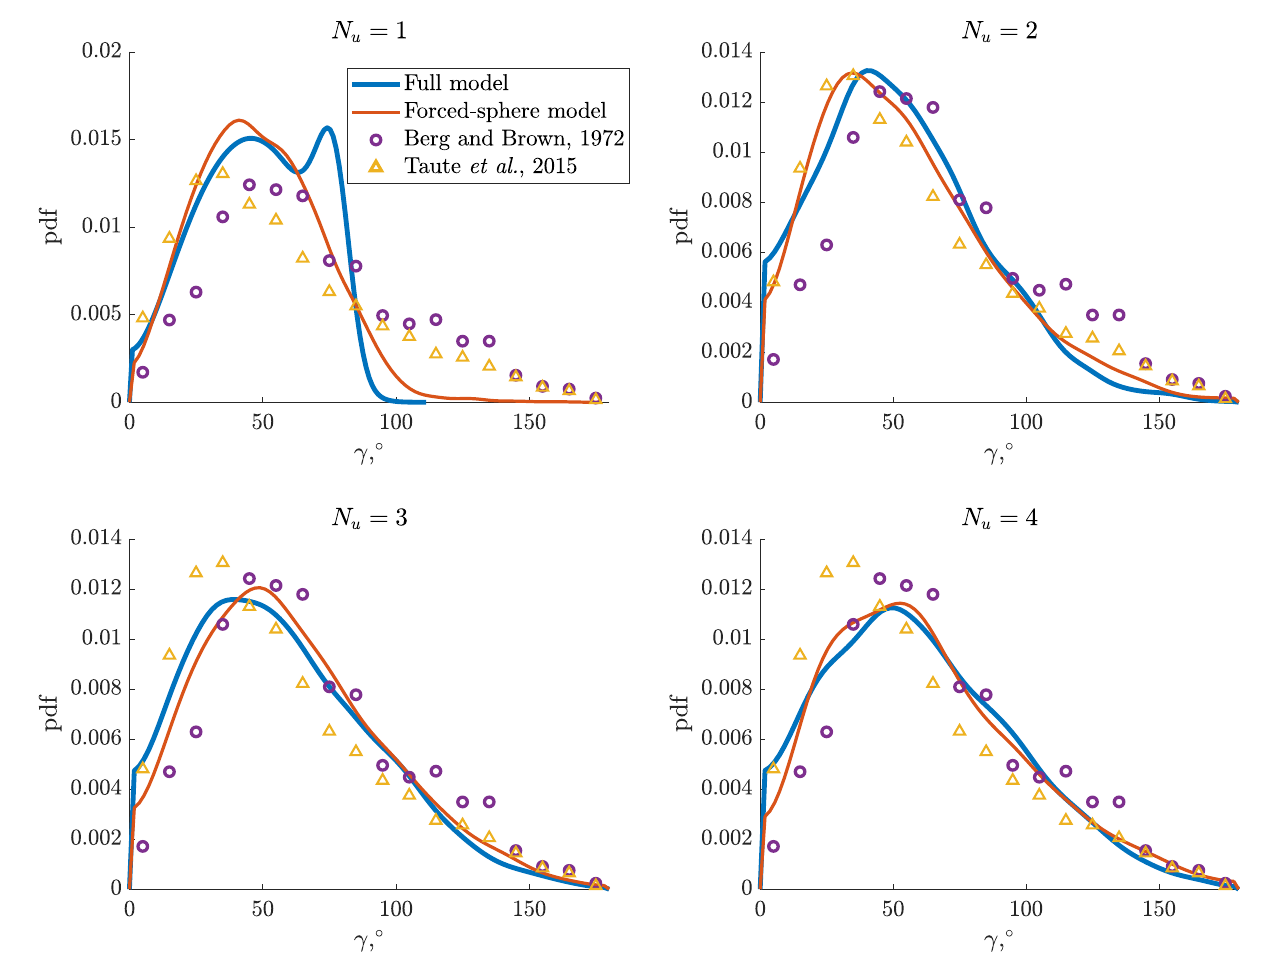
Fig 8. Probability density functions (pdfs) for the change-of-direction angle γ of a cell during a tumble. For each cell, the filaments in the bundle are aligned with the z -axis and remains in the normal polymorphic form, while N = 1 to 4 filaments undergo polymorphic transformations during the u tumble. The blue line shows the results produced by our full theoretical model described in Section 2 while the red line displays the results of the simplified forced-sphere model from Section 4. The experimental data of Berg and Brown [38] are shown purple circles while the data of Taute et al . [42] are shown using yellow